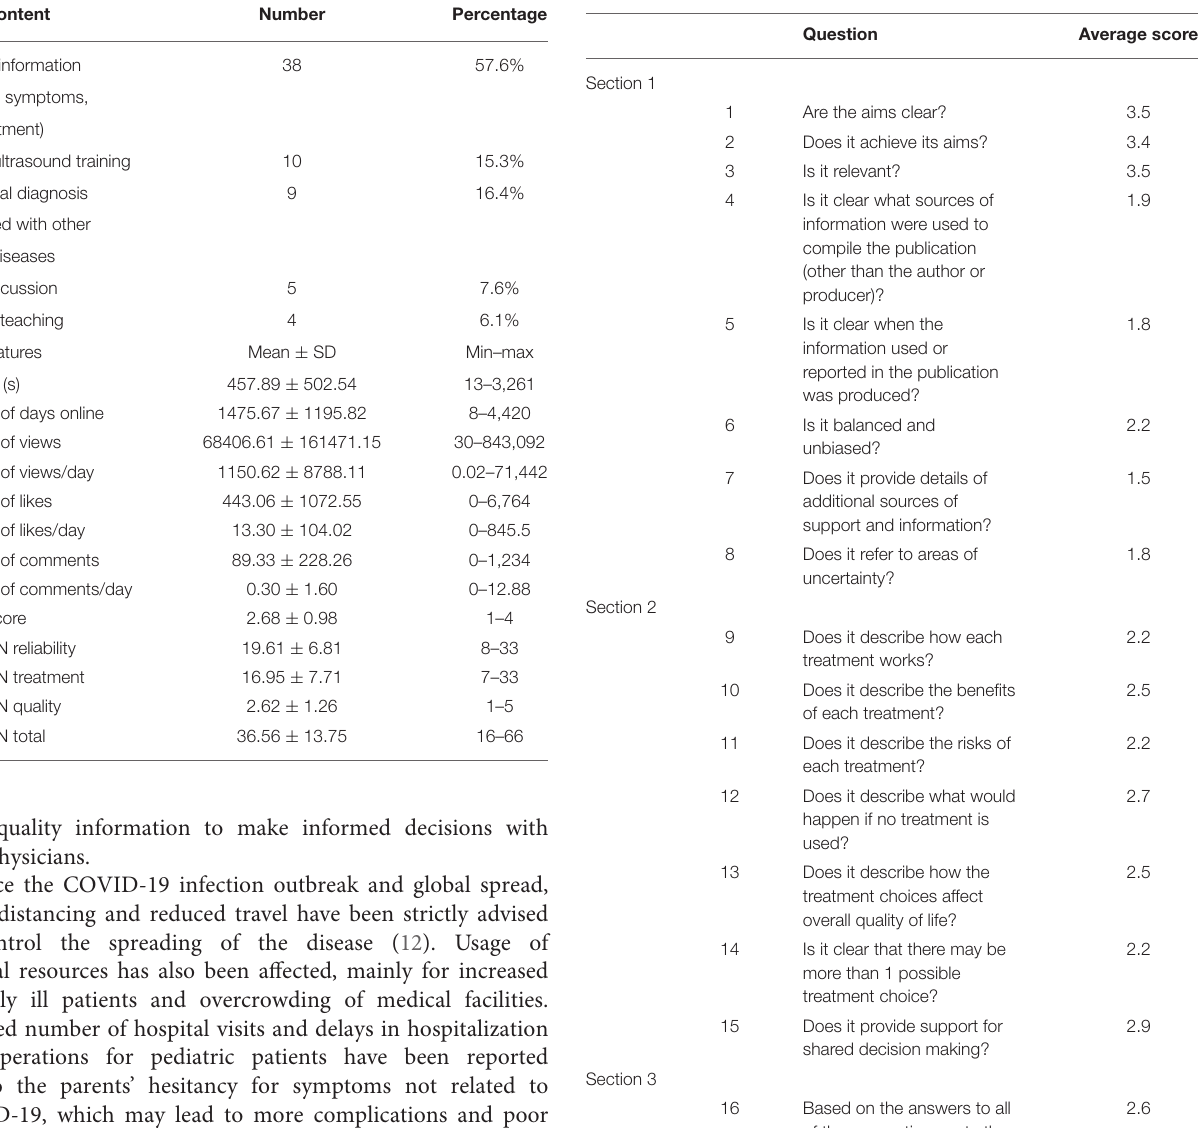
TABLE 1 | Characteristics and quality assessments of YouTube videos. TABLE 2 | Average score per DISCERN question among all included YouTube